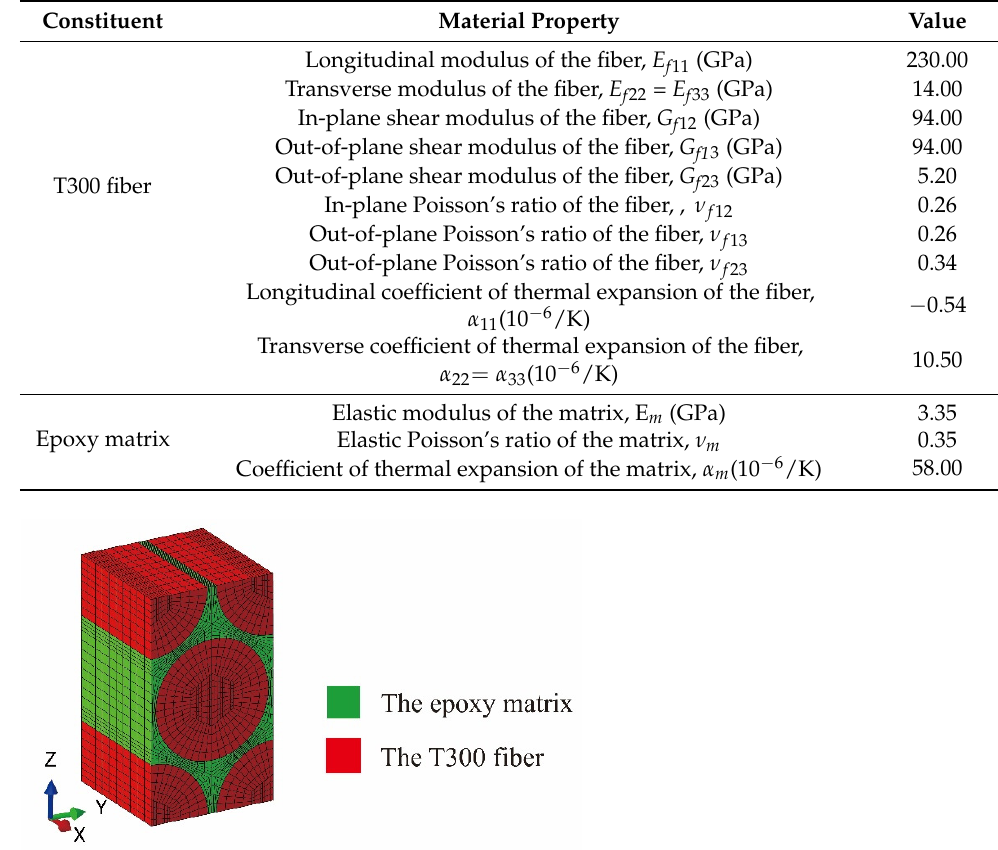
Table 8. Mechanical properties of the fiber and matrix constituents in the T300/Epoxy composite.